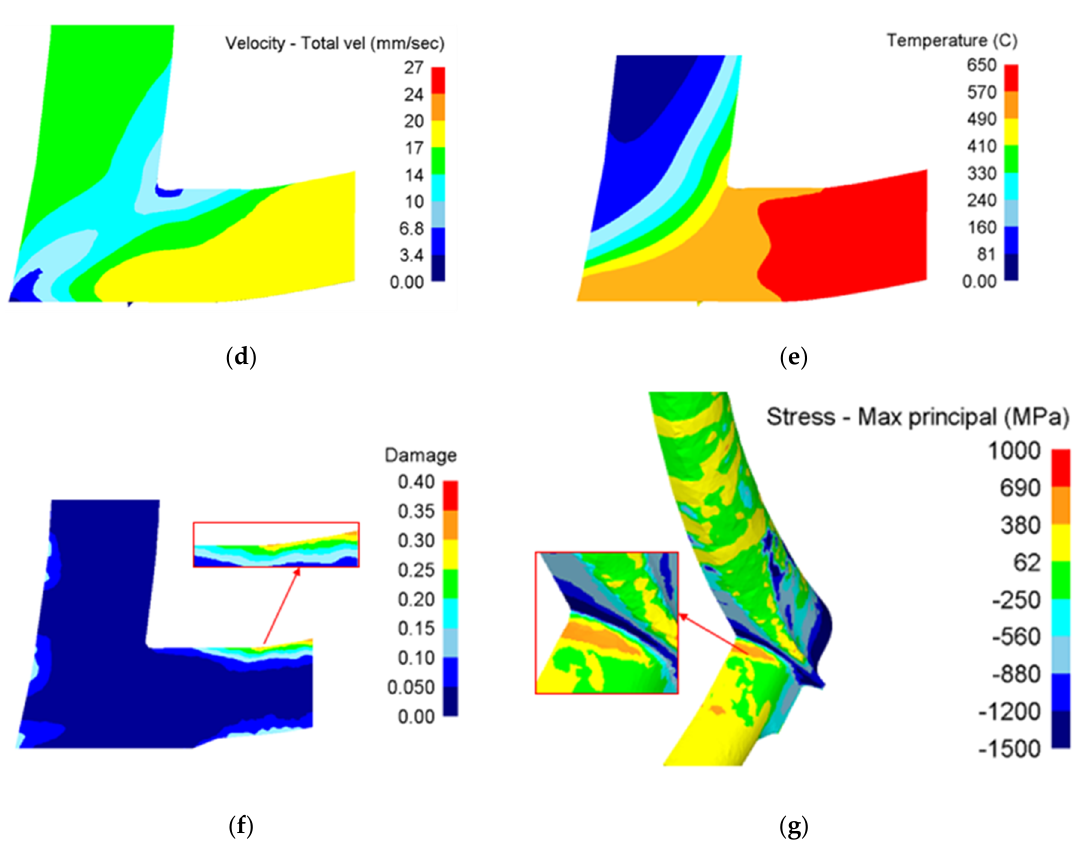
Figure 3. Results of numerical modelling of the Conform SPD process: ( a ) finite element model of the Conform SPD process, ( b ) effective strain rate field, ( c ) effective strain field, ( d ) total velocity field, ( e ) temperature field, ( f ) damage area and ( g ) maximal stress during processing.